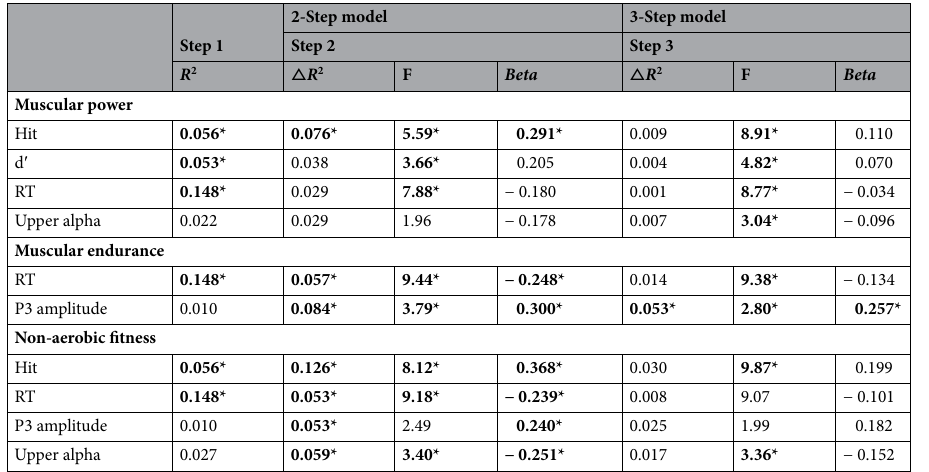
Table 3. The summary of the 2-step and 3-step hierarchical regression analyses using non-aerobic fitness or its subcomponent as a predictor. Muscular power, muscular endurance, and non-aerobic fitness are the predictors. The behavioral (Hit, d ′ , RT) and neuroelectric (P3 amplitude, lower alpha ERD, upper alpha ERD) are the dependent outcome variables. In each regression analysis for each dependent outcome variable, the same demographic variable that was correlated with the dependent outcome variable was entered in Step 1 of both the 2-step and 3-step models. For 2-step models, muscular power, muscular endurance, and non-aerobic fitness were entered into the Step 2. For 3-step models, motor competence was entered into the Step 2, and muscular power, muscular endurance, and non-aerobic fitness were entered into the Step 3. Bolded values with a * denote significance at p <